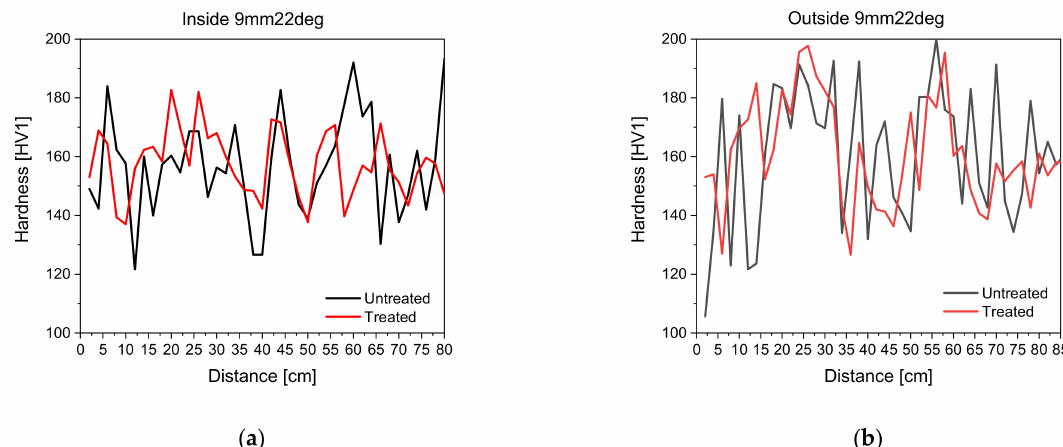
Figure 5. Development of UCI hardness on treated and untreated surfaces along the inside and outside of the steel tube; ( a ) UCI hardness development on untreated and treated surfaces on inside of steel tube 9 mm 22 deg; ( b ) UCI hardness development on untreated and treated surfaces on outside of steel tube 9 mm 22 deg.